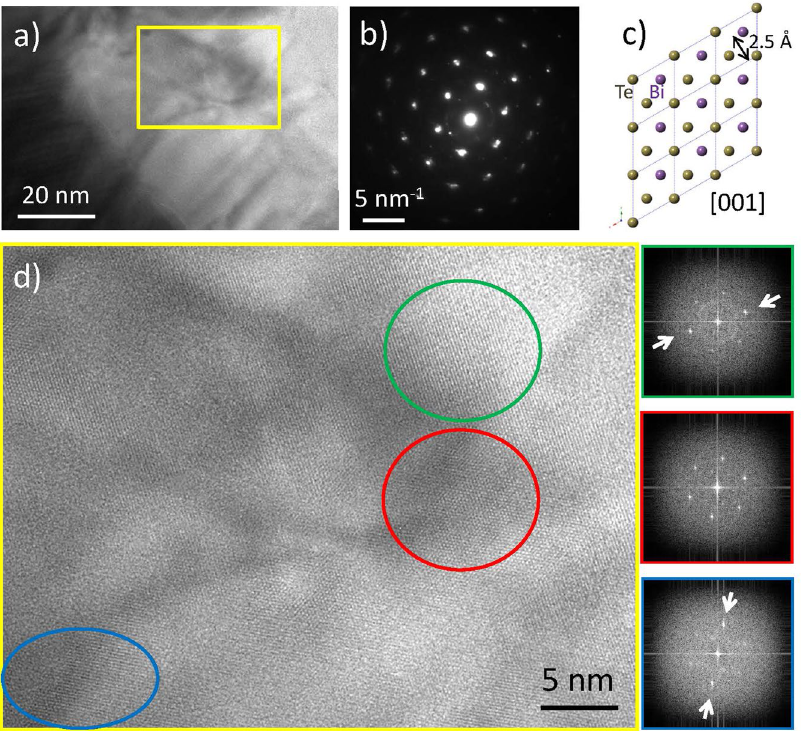
Figure 5. TEM study of a nominal Bi 0.35 Sb 1.65 Te 3 crystal. ( a ) Low magnification bright field image ( b ) along with the diffraction pattern measured over this area. Most of the grain is oriented down the [001] zone axis. ( c ) Corresponding crystal model. ( d ) High resolution zoom into the area highlighted with a yellow rectangle in a), where a number of varying crystal orientations can be detected. A red circle depicts an area with a [001] orientation, while the green and blue circles mark adjacent regions that are slightly off in terms of local orientation. Accordingly, the areas marked in green, red and blue exhibit different features in the Fourier transforms (panels on the right, from top to bottom